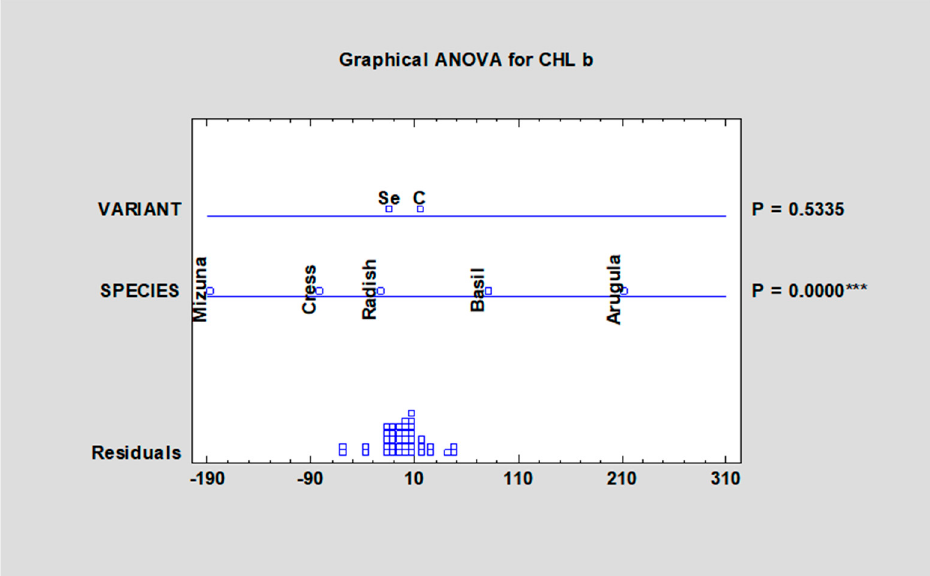
Figure 4. Chlorophyll b content in microgreens species after fortification with sodium selenate. Fw — fresh weight, control; SeAp — selenium application (2 mg Se/L), *** statistically significant